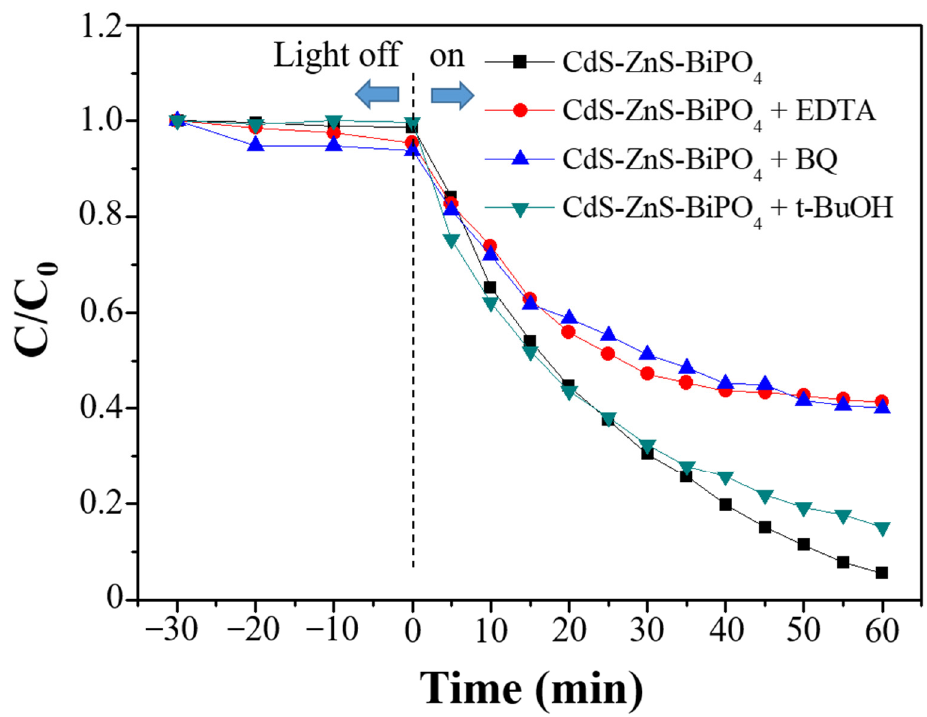
Figure 7. Trapping experiments of the CdS-ZnS-BiPO 4 nanocomposites for MB degradation (C/C 0 ) under visible light irradiation: EDTA, BQ, and t-BuOH (each 2 mM) were scavengers for holes, oxygen radicals, and hydroxyl radicals, respec- tively.